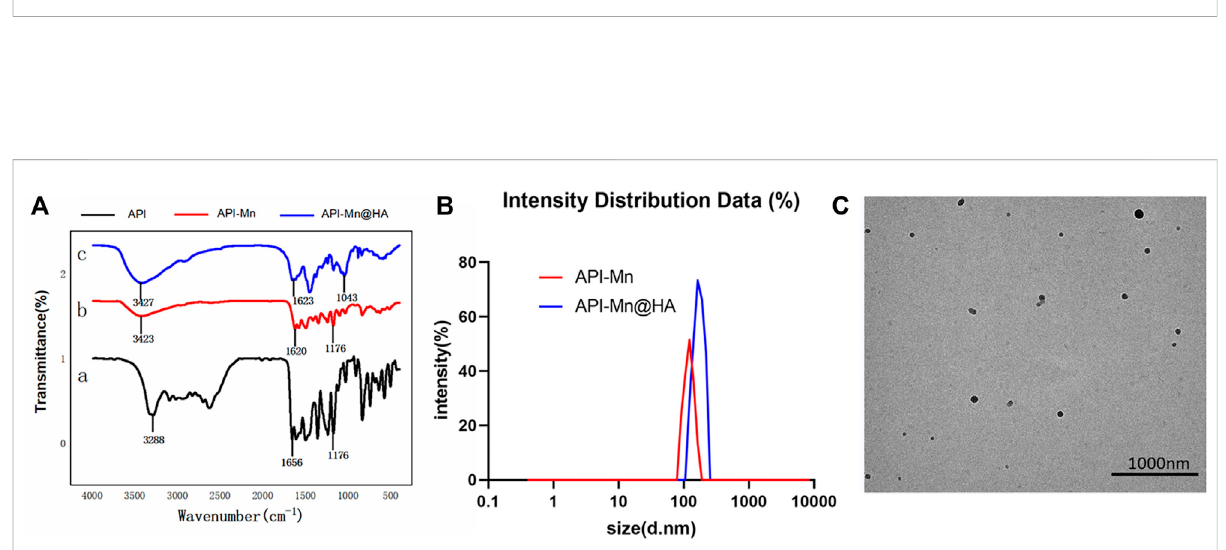
FIGURE 1 Response surface and contour line of the in fl uence of each factor interaction on yield. (A) . Response surface of pH and time to yield. (B) . ResponsesurfaceandcontourofpHandtemperatureeffectsonyield. (C) .Responsesurfaceandcontourlinesfortheeffectoftimeandtemperature on yield. (D) . The curve of the molar ratio method.